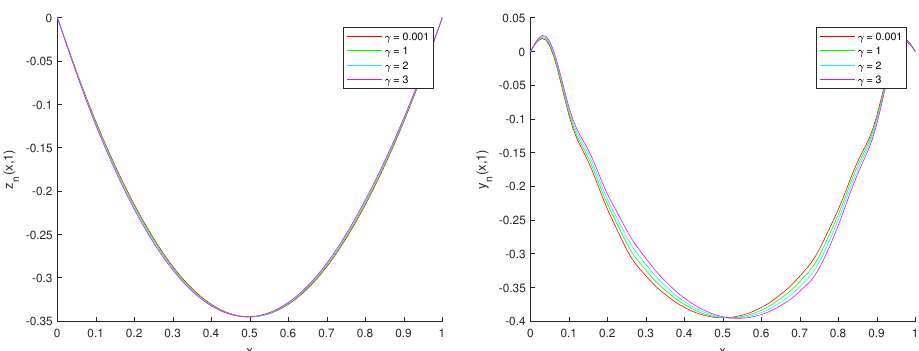
Figure 4. Example 2: displacement and velocity of the fluid for different values of parameter γ .